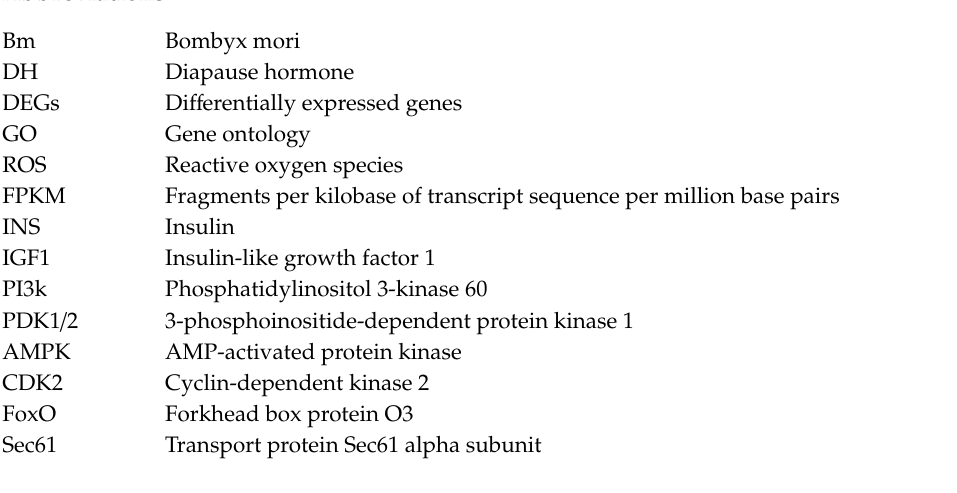
Figure S1: Transcript expression level distribution in silkworm diapause eggs at 20 and 48 h after oviposition. Y -axis represents logarithmic values of fragments per kilobase of transcript sequence per million base pairs sequenced (FPKM), and x -axis represents box plot of FPKM distribution of di ff erent samples. Figure S2: Pearson correlation analysis of di ff erentially expressed genes in silkworm diapause eggs at 48 h vs. that at 20 h after oviposition. Table S1: Fragments per kilobase of transcript sequence per million base pairs sequenced of 17,967 silkworm genes in silkworm diapause eggs at 48 h vs. that at 20 h after oviposition. Table S2: Di ff erentially expressed genes in silkworm diapause eggs at 48 h vs. that at 20 h after oviposition. Table S3: Gene ontology (GO) term enrichment of di ff erentially expressed genes in silkworm diapause eggs at 48 h vs. that at 20 h after oviposition. Table S4: Kyoto Encyclopedia of Genes and Genomes (KEGG) pathway enrichment of di ff erentially expressed genes in silkworm diapause eggs at 48 h vs. that at 20 h after oviposition. Table S5: Information of the genes for quantitative polymerase chain reaction validation. Table S6: Di ff erentially expressed genes (DEGs) of respiratory complexes in oxidative phosphorylation pathway. Table S7: Di ff erentially expressed genes (DEGs) of correctly folded and misfolded proteins in protein processing in endoplasmic reticulum pathway. Table S8. Di ff erentially expressed genes (DEGs) of the core autophagy-related in autophagy